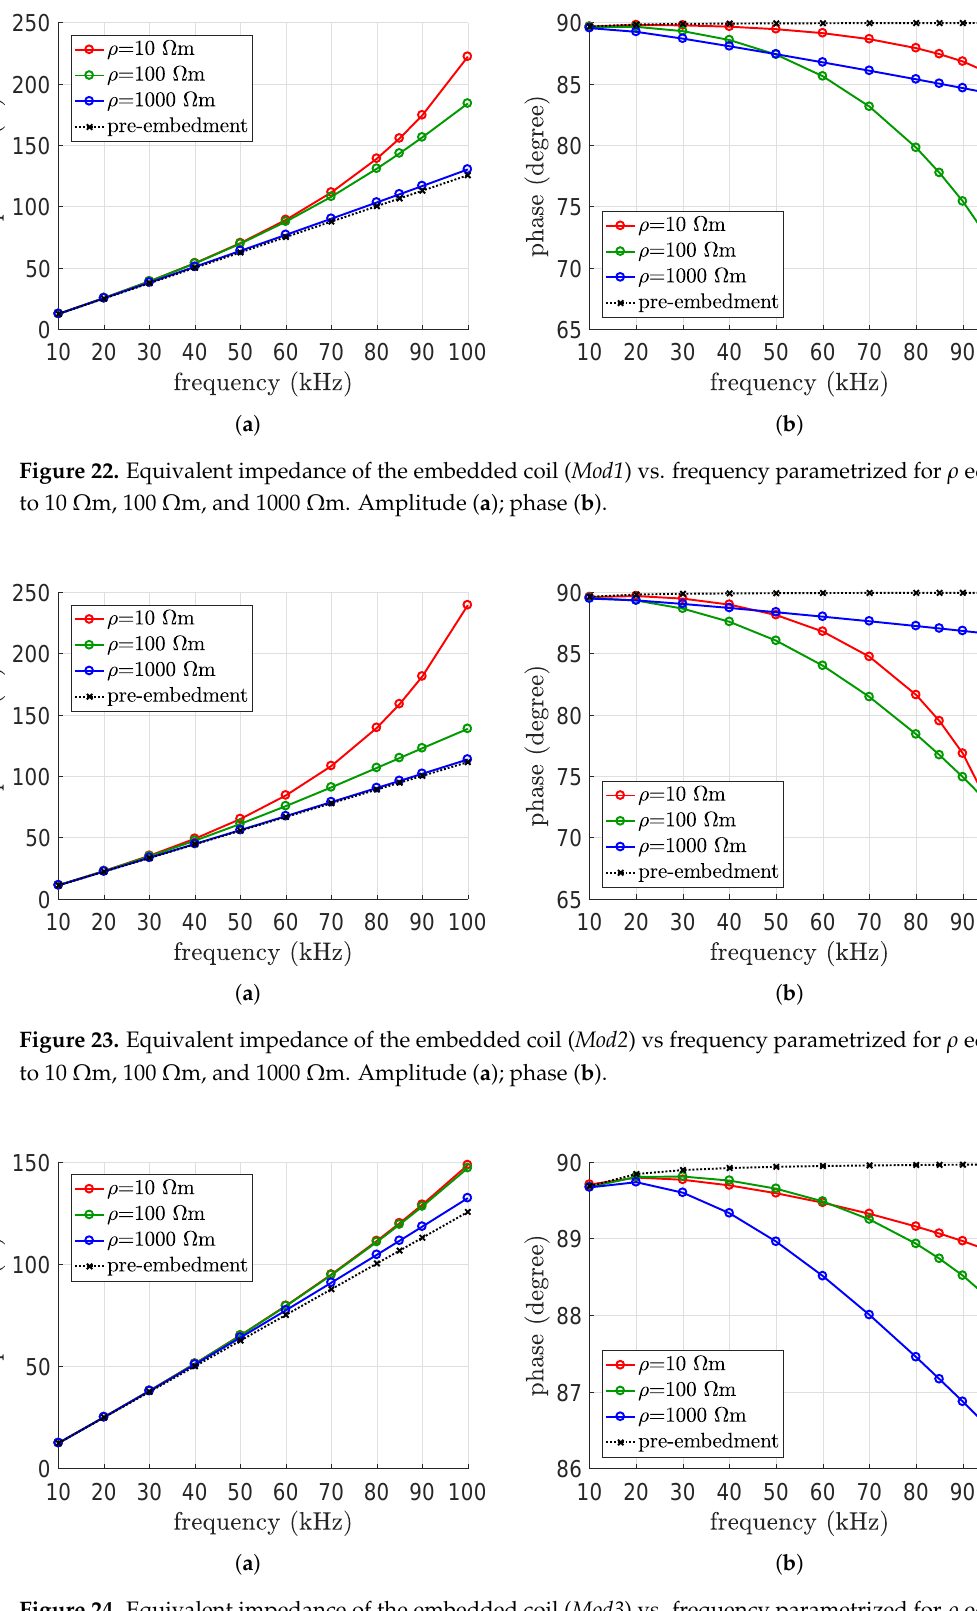
Figure 24. Equivalent impedance of the embedded coil ( Mod3 ) vs. frequency parametrized for ρ equal to 10 Ω m, 100 Ω m, and 1000 Ω m. Amplitude ( a ); phase ( b